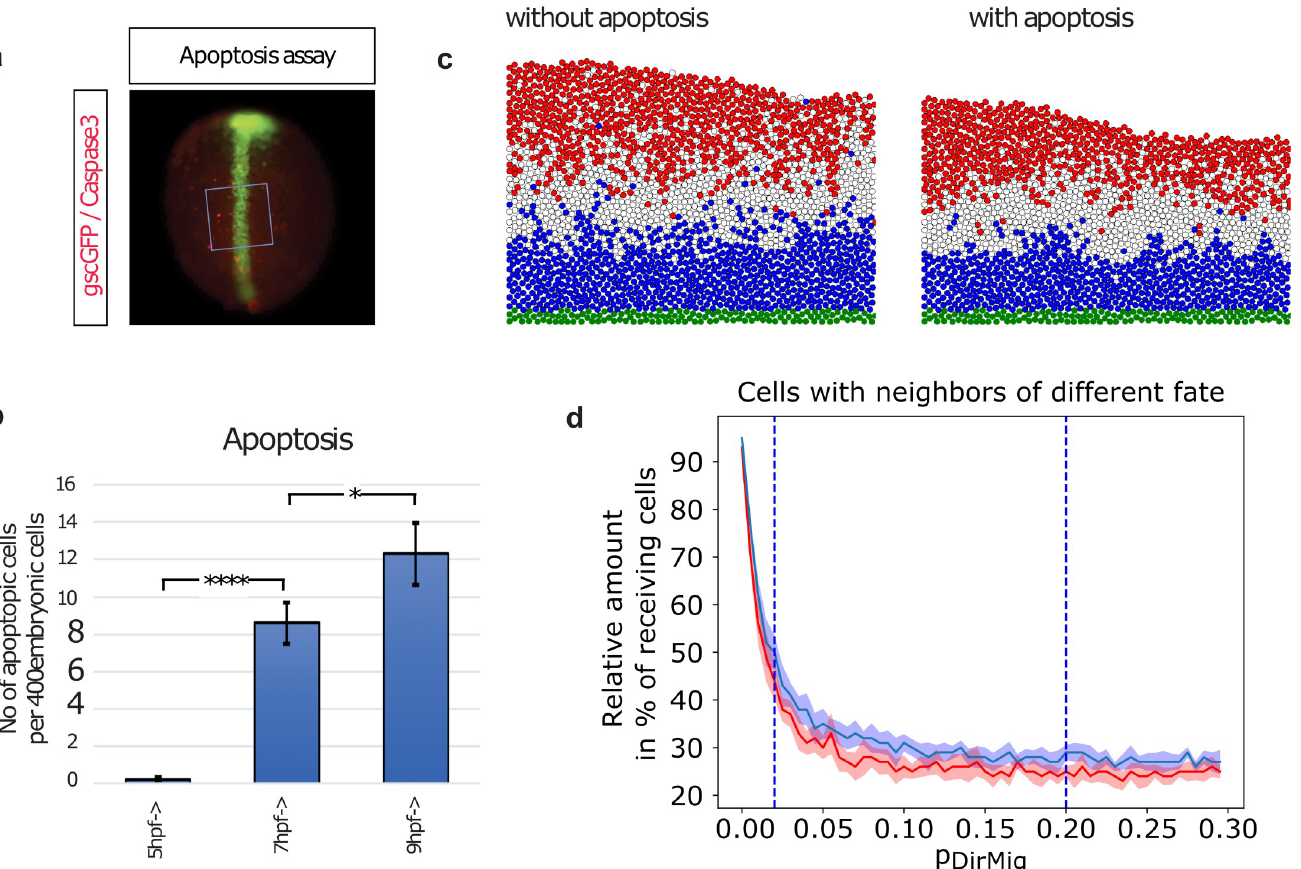
Fig 4. Apoptosis further improves neural plate patterning. To determine the number of apoptotic cells in the developing embryo, immunohistochemical staining against Caspase3 is performed at 5 hpf, 7 hpf, and 9 hpf. a) , After antibody staining, 10 areas of ca 20 by 20 cells are placed randomly over the dorsal hemisphere of the embryos (marked by gsc -GFP expression) and within these squares of ca 400 cells, the number of apoptotic cells is counted. b) At 5 hpf, no apoptotic cells are detected. At 7 hpf 2% and at 9 hpf 3% apoptotic cells are observed. c) Induced apoptosis of a similar relative number of cells as experimentally determined are implemented into our simulations. The simulation of cytoneme based Wnt-transport with weak sorting and no induced apoptosis (left) is compared to the simulation with additionally enabled induced apoptosis (right) at t = t TRS = 180 min. Cell fates and coloring are as in Fig 1. d) Increasing the sorting parameter p DirMig during the directed transport simulations leads to decreased mixing of cell fates (red with, blue without apoptosis). Even large values for p DirMig , however, cannot remove truly isolated cells (cf. c)). Adding limited apoptosis (130 cells over entire simulation) can eliminate these cells and leads to an additional improvement. Displayed is the development after t = 180 min averaged over 10 simulations for each value of p DirMig , with p DirMig = 0.02 and p DirMig = 0.2 (cf. Fig 4) highlighted.